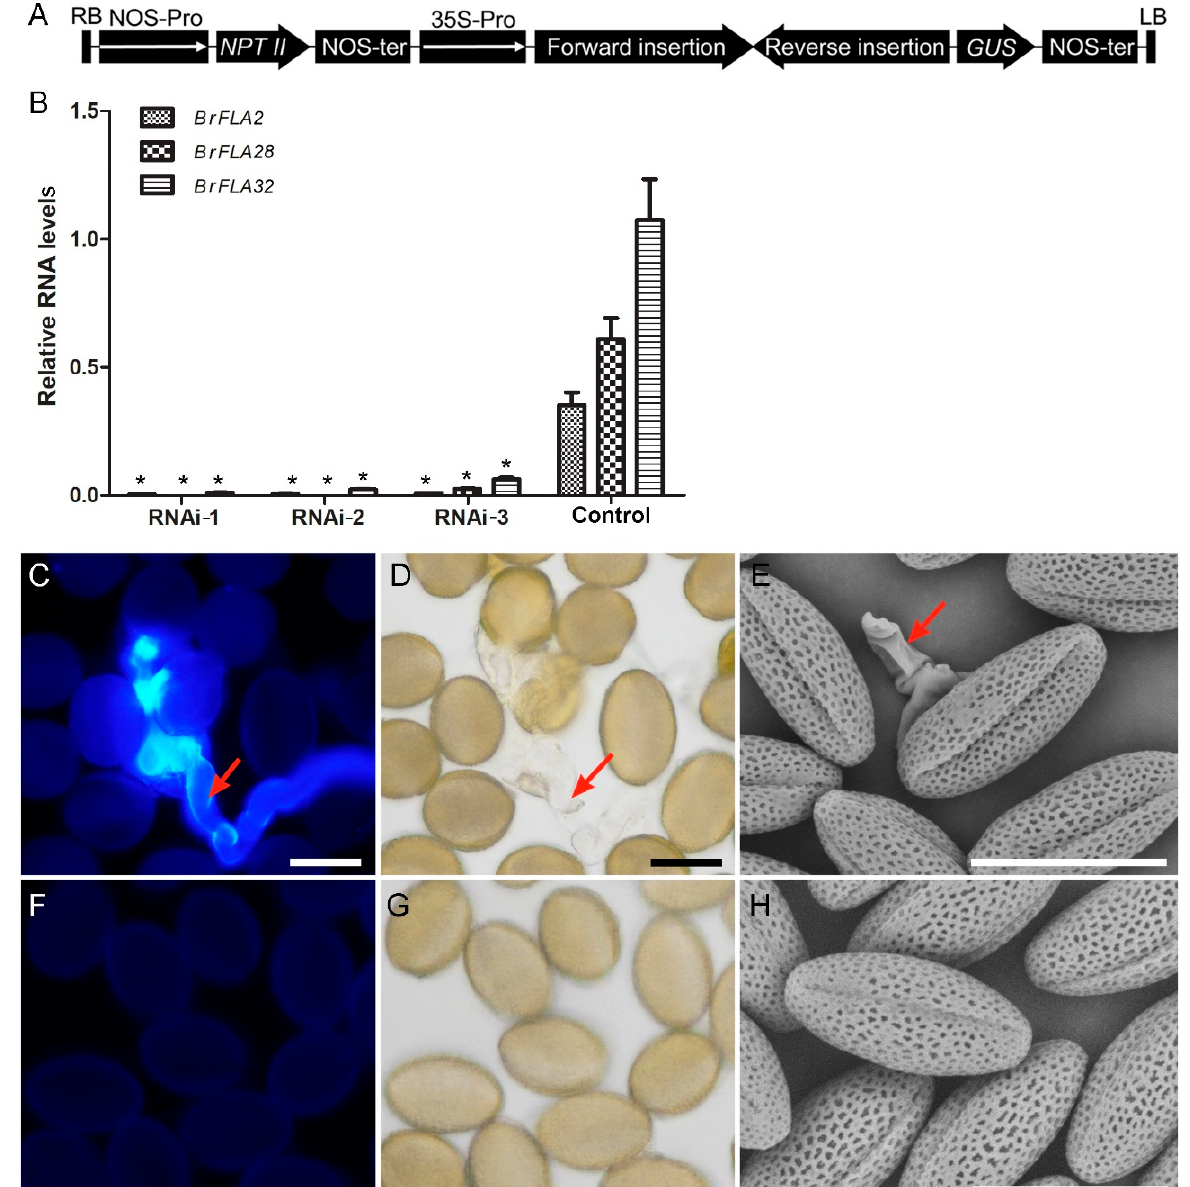
Figure 7. Effects of 85% relative humidity on dehiscent pollen of BrFLA2/28/32 –RNAi transgenic plants in Brassica rapa . ( A ) Schematic representation of the T-DNA portion of RNAi recombinant plasmid. ( B ) Expression of BrFLA2 , BrFLA28 and BrFLA32 in RNAi plants by quantitative real-time PCR. RNA was extracted from the inflorescence. The values are the mean ± standard deviation (SD). * indicates significantly different means ( p < 0.05) using one-way ANOVA. ( C – H ) Effects of 85% relative humidity on dehiscent pollen after 3d. ( C , D ) Pollen from a BrFLA2/28/32 –RNAi plant stained with aniline blue. ( D ) The corresponding bright field image. ( E ) Pollen from a BrFLA2/28/32 –RNAi plant observed under scanning electron microscopy. ( F , G ) Pollen from a control plant stained with aniline blue. ( G ) The corresponding bright field image. ( H ) Pollen from a control plant observed under scanning electron microscopy. Scale bars = 30 µ m ( C – H